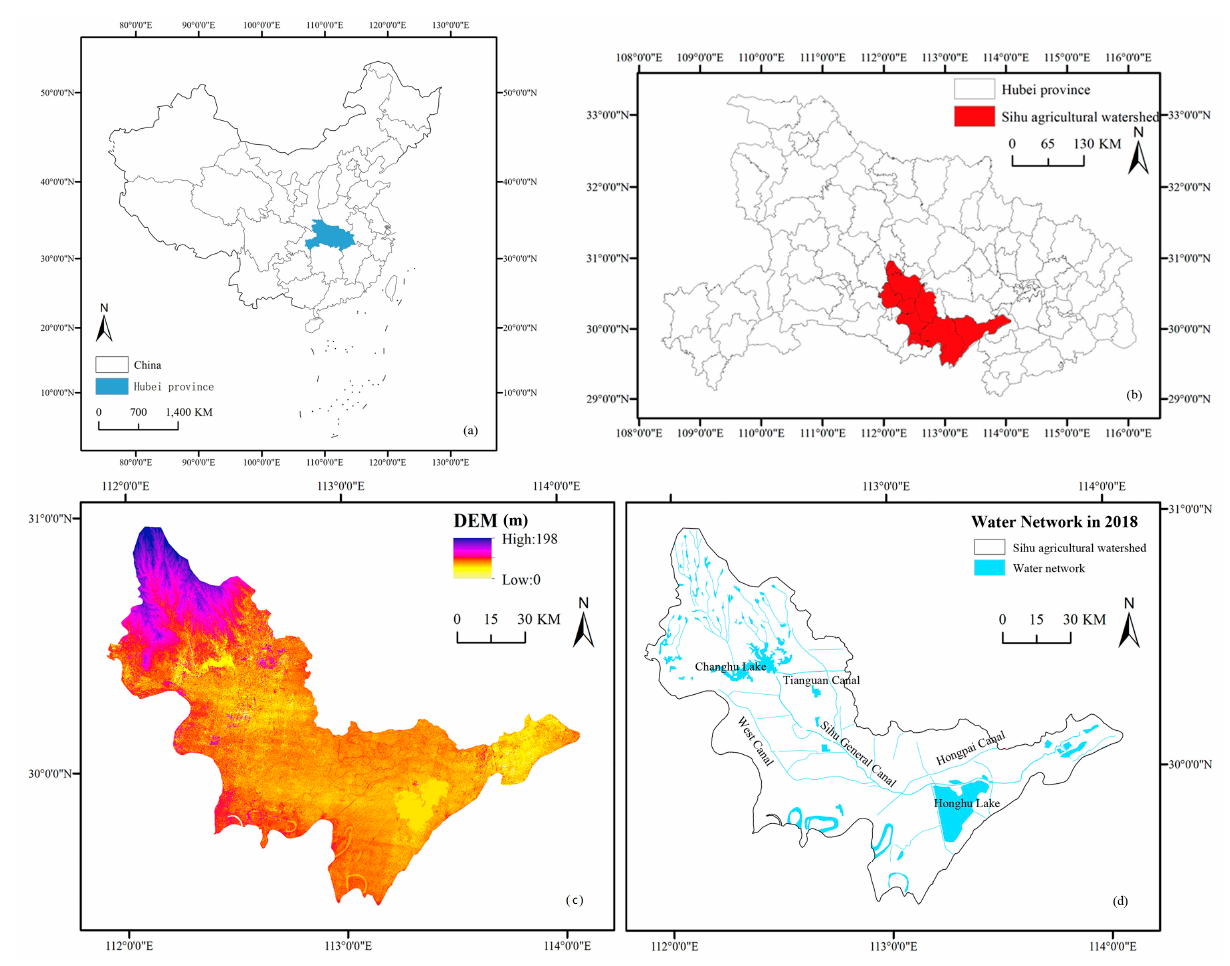
Figure 1. Geographic location, DEM and water network of the study area ( a – d ).